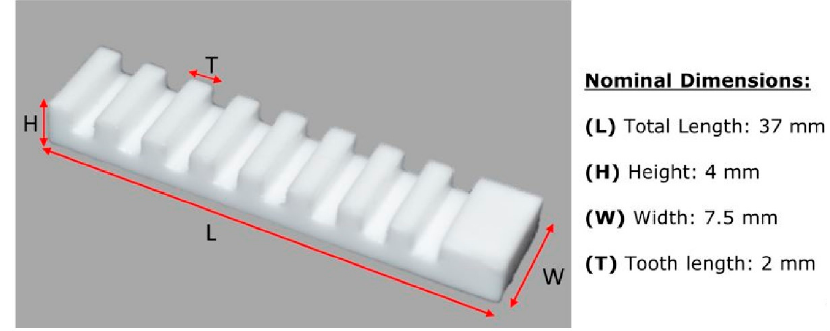
Figure 14. TCP miniature step gauge manufactured by Lithoz.